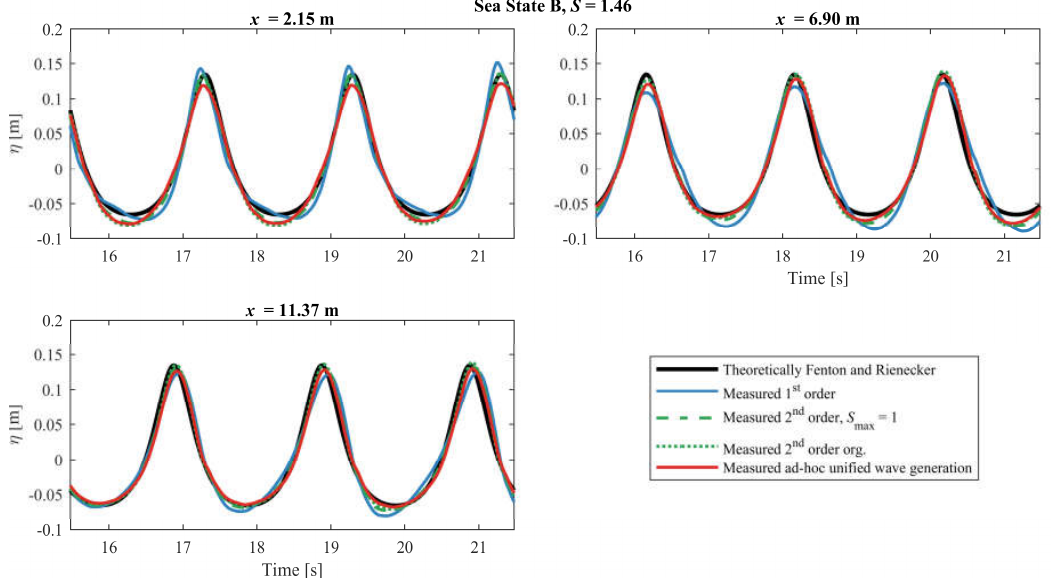
Figure 6. Theoretically surface elevation compared with the first-order, second-order, modified second-order and the ad-hoc unified wavemaker methods for Sea State B.